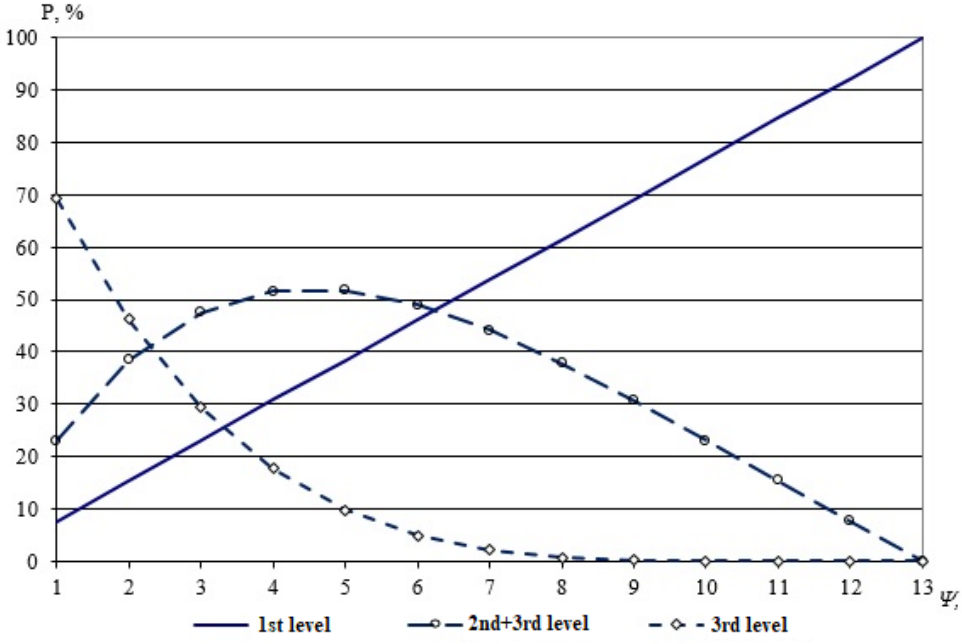
Figure 4. Dependence of the probability of hitting the nodes (P) of the system levels on destructive influences.